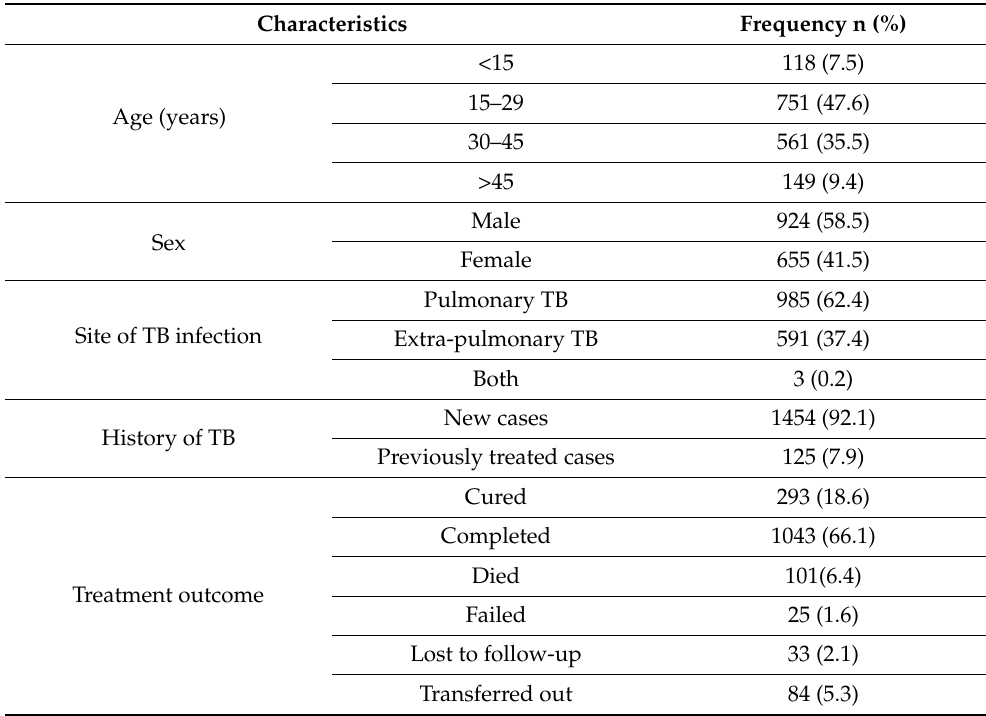
Table 1. Demographic and clinical characteristics of patients from the TB DOTS clinic logbook (N = 1579) at public-health facilities, Northeast Ethiopia, from January to April 2018.